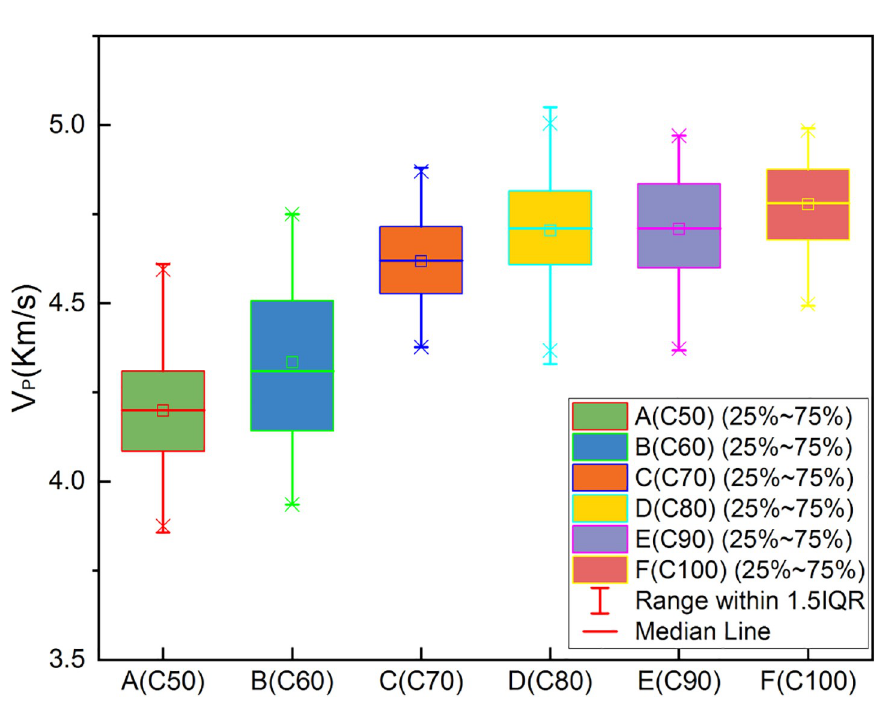
Fig 7. Boxplot of experimental data (V P ).